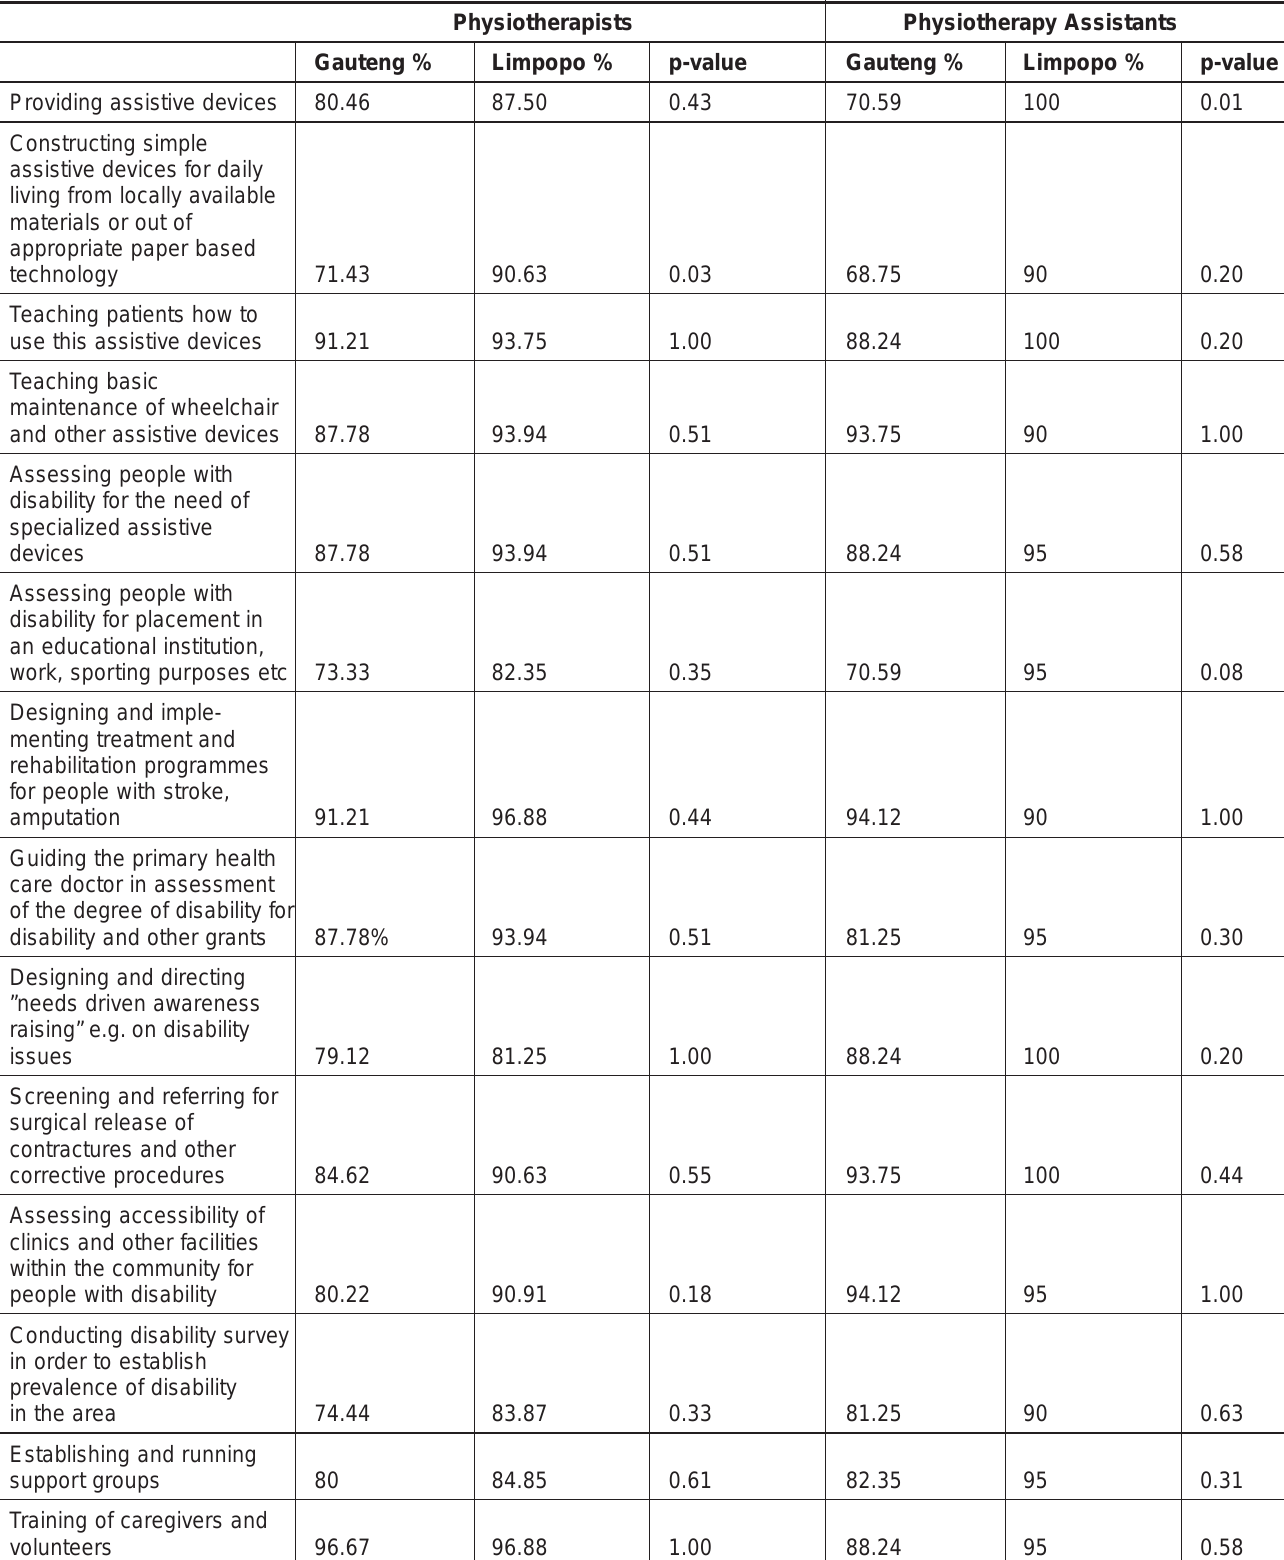
Table 7: Rehabilitation